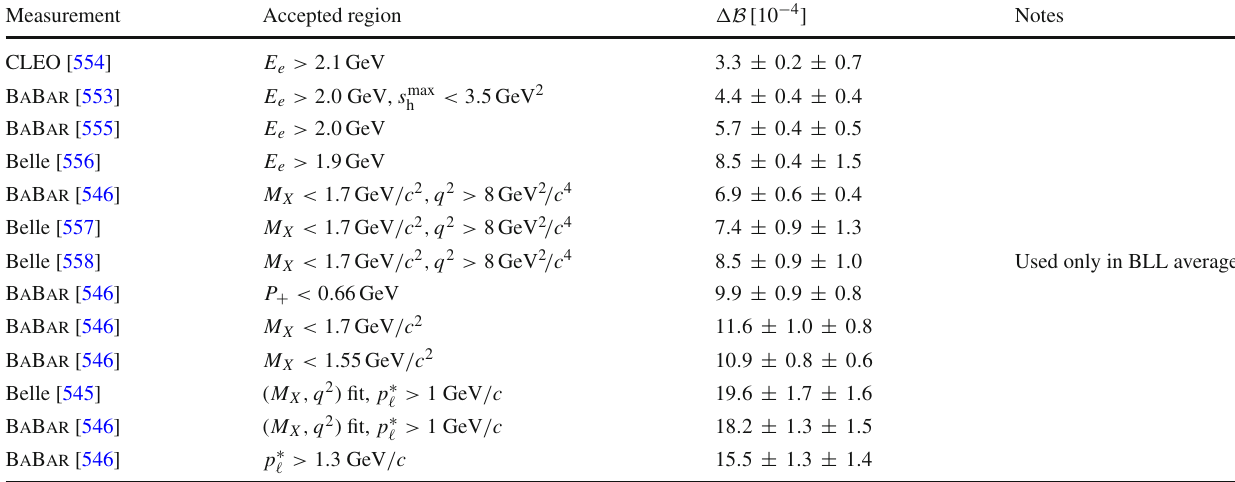
Table 89 Summary of measurements of partial branching fractions for B → X u (cid:12) + ν (cid:12) decays. The errors quoted on (cid:5) B correspond to statisti- cal and systematic uncertainties. E e is the electron energy in the B rest frame, p ∗ the lepton momentum in the B frame and m X is the invariant